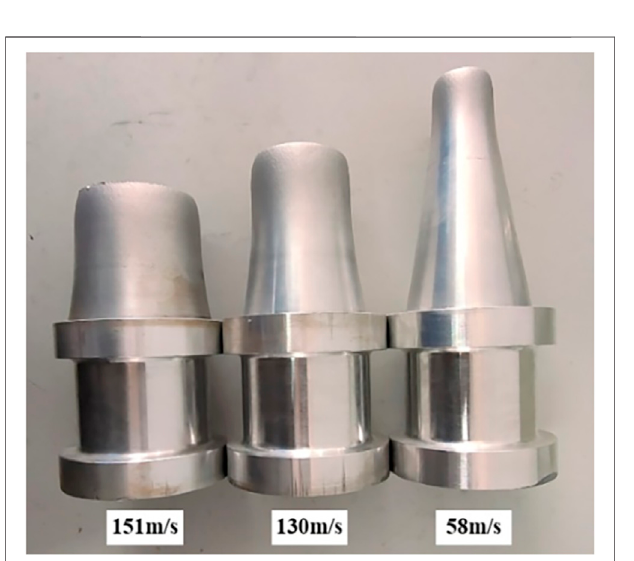
FIGURE12 | Comparison of test projectiles after impact.